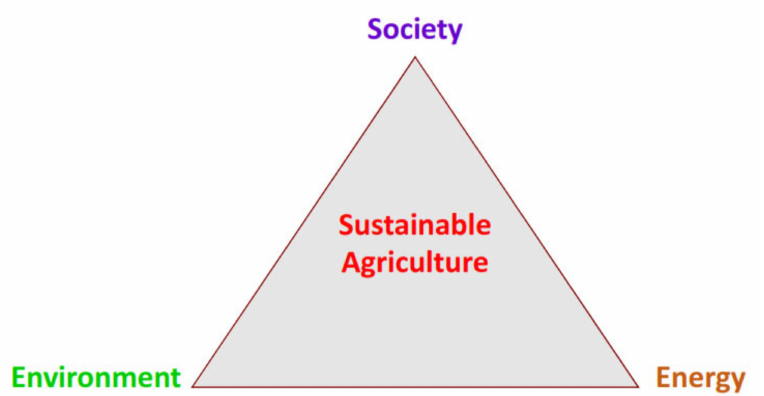
Figure 1. Factors of sustainable agriculture.